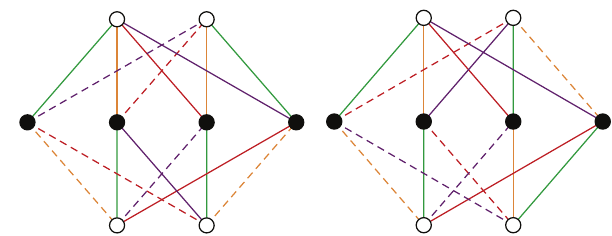
Figure 5: Two equivalent, nonisomorphic Adinkras with the same values of 𝜇(ℎ,𝑎) , for all possible values of ℎ and 𝑎